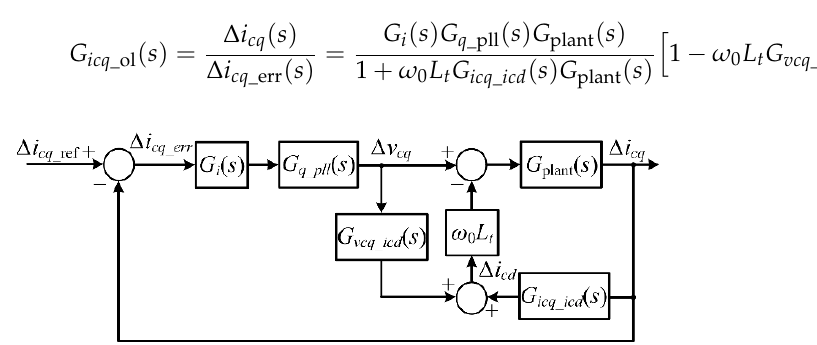
Figure 4. Control in the q- axis without voltage droop.